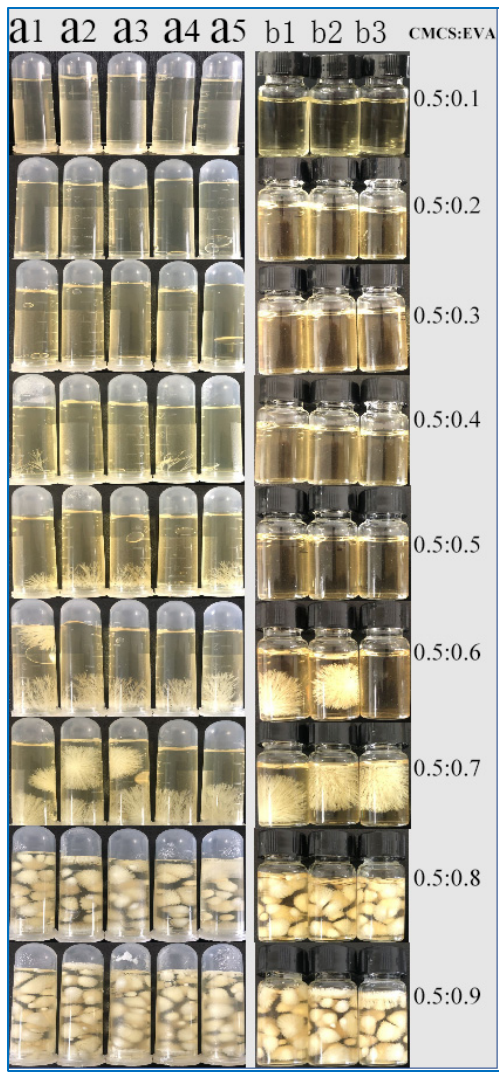
Figure 1. EVA crystallization from CMCS gels with di ff erent concentration ratio ( a1–a5 and b1–b3 ) in centrifuge tube ( fi ve repeats a1–a5 ) and ampoule bo tt le (three repeats b1–b3 ).